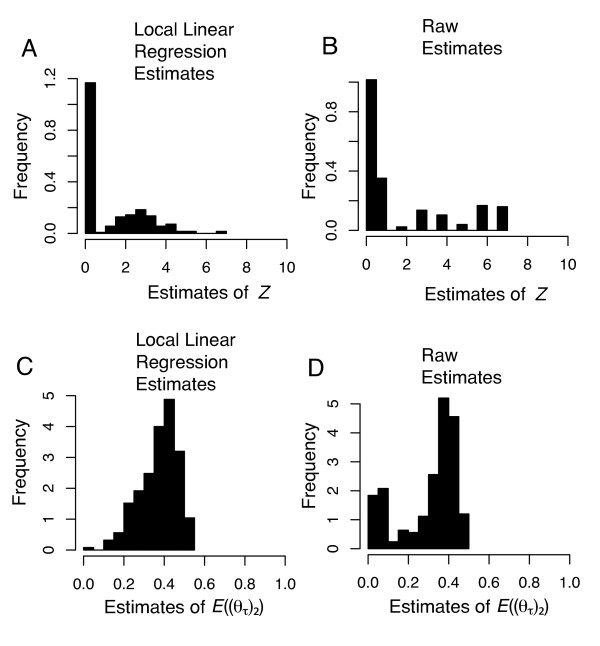
Estimator performance under constrained history of asymmetrical soft vicariance (True Z = 0; True E((θτ)2) < 0.05; stage 1 model). Each panel depicts a frequency histogram of 250 mode estimates of Z (A and B) and E((θτ)2) (C and D) under a constrained history of asymmetrical soft vicariance where Z = 0 and E((θτ)2) < 0.05. For all mode estimates, tolerance was 0.001 (2,000 accepted draws). Mode estimates for panels (A) and (C) are obtained using the local linear regression algorithm, whereas the mode estimates for panels (B) and (D) are obtained using the raw 2,000 accepted values.